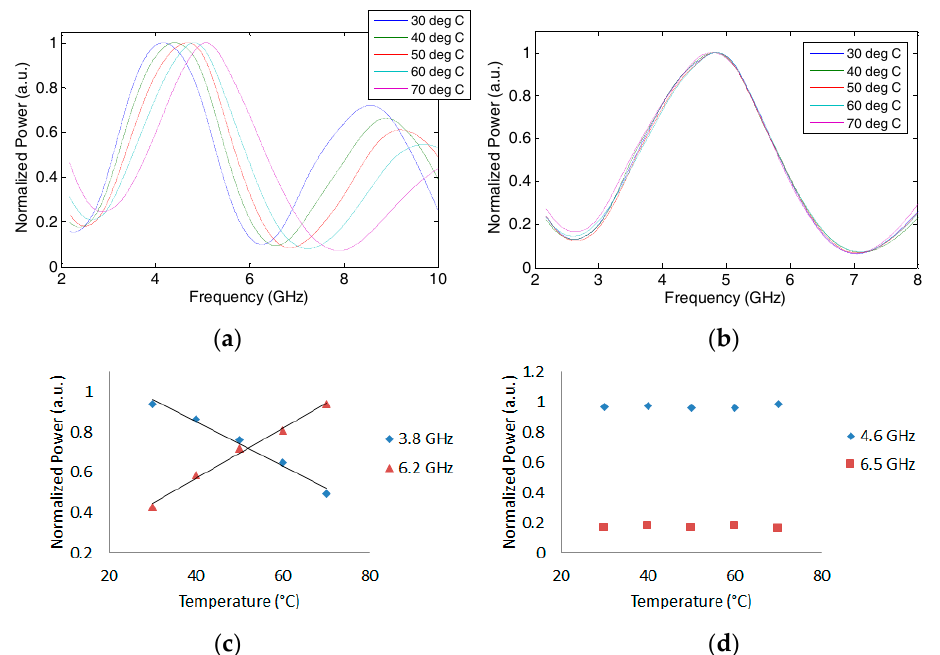
Figure 10. Characteristics of Sensor 1 as the temperature is increased from 30 °C to 70 °C, while Sensor 2 is maintained at a constant (room) temperature. MWP filter responses for Sensor 1 ( a ) and Sensor 2 ( b ) and corresponding normalized RF power vs. temperature at frequencies of 3.8 GHz and 6.2 GHz (for Sensor 1) and 4.6 GHz and 6.5 GHz (for Sensor 2).